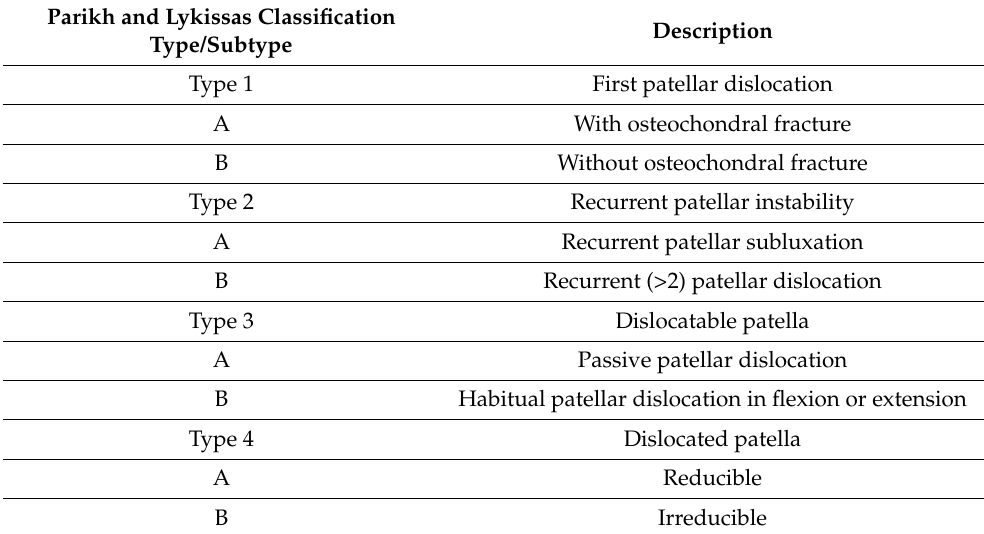
Table 1. Classification of patellar instability according to Parikh and Lykissas